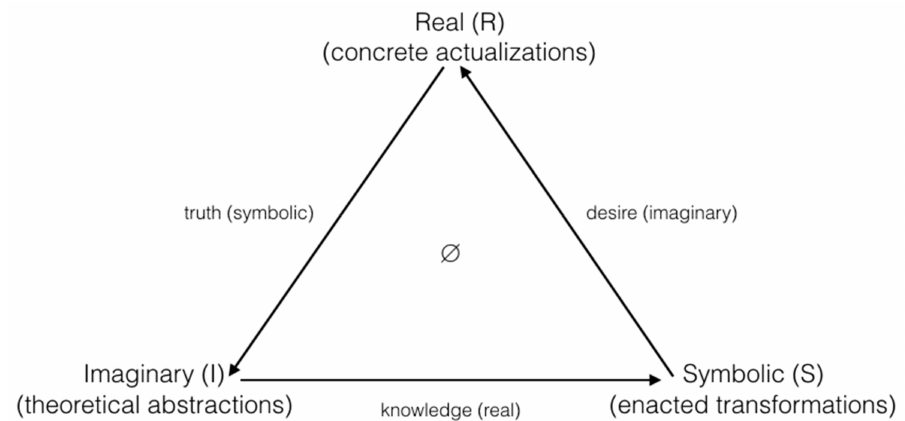
Figure 7. Structural transformations on the transcendental horizon: triad. This structure represents an attempt to formalize the geometry of the mental space which becomes entangled with the world. From this entanglement we see the motion of the dynamical geometry of the mental space as concretizing new reals from knowledge by processing imaginary desire through symbolic truth acts. First, the subject that intervenes/transforms emerges from the concrete real in relation to an imaginary field or screen. This field or screen becomes the invisible location of the subject’s thought on its perceptual horizon of becoming and reveals to the subject an object of desire which motivates it to intervene/transform the real towards a more ideal order. The subject achieves such interventions/transformations through introducing the symbolic to the real in the form of speech, writing, poetry, song, equations, jokes, and various other formalisms. From introducing the symbolic into the real the subject becomes fundamentally entangled, correlated, and/or caught up in a web of interactions with the real and thus measures its symbolic on the terms of which the real returns its message as truth (intervention/transformation). In these processes all three elements of the imaginary-symbolic-real are simultaneously co-present: the real of knowledge is present when the imaginary theoretical abstractions collapse into enacted symbolic transformations; the imaginary of desire is present when enacted symbolic transformations attempt a real concrete actualization; and the symbolic truth is there when the real of concrete actualizations informs theoretical abstractions of the imaginary. In this scheme ‘knowledge’ is ‘real’ because knowledge is the concrete actualization of the subject, ‘desire’ is ‘imaginary’ because desire represents an absent actualization, and ‘truth’ is ‘symbolic’ because truth is what returns to the subject from the real (an ‘answer’ from the real that ‘emerges’ due to our own interventions/transformations). In order to interpret and utilize this structural triad it is crucial that one conceives of it as always-already (‘eternally’) in motion and constantly re-setting its coordinates in a network of such structures which compose the geometric space of the four-dimensional transcendental horizon. The central Ø denotes that ‘beyond’ or ‘behind’ the transcendental horizon there is nothing other than the void of our subjectivity which we project (imaginary) and enact (symbolic) into the real. In this way such an analysis attempts to think a dynamical real virtual thing-in-itself (between order-chaos, dreams-obstacles, goals-challenges, presences-absences etc.) that is both open and incomplete making the ‘thing’ dependent on subjectivity for its own identity and becoming due to a division that is fundamental for the appearance of subjectivity as